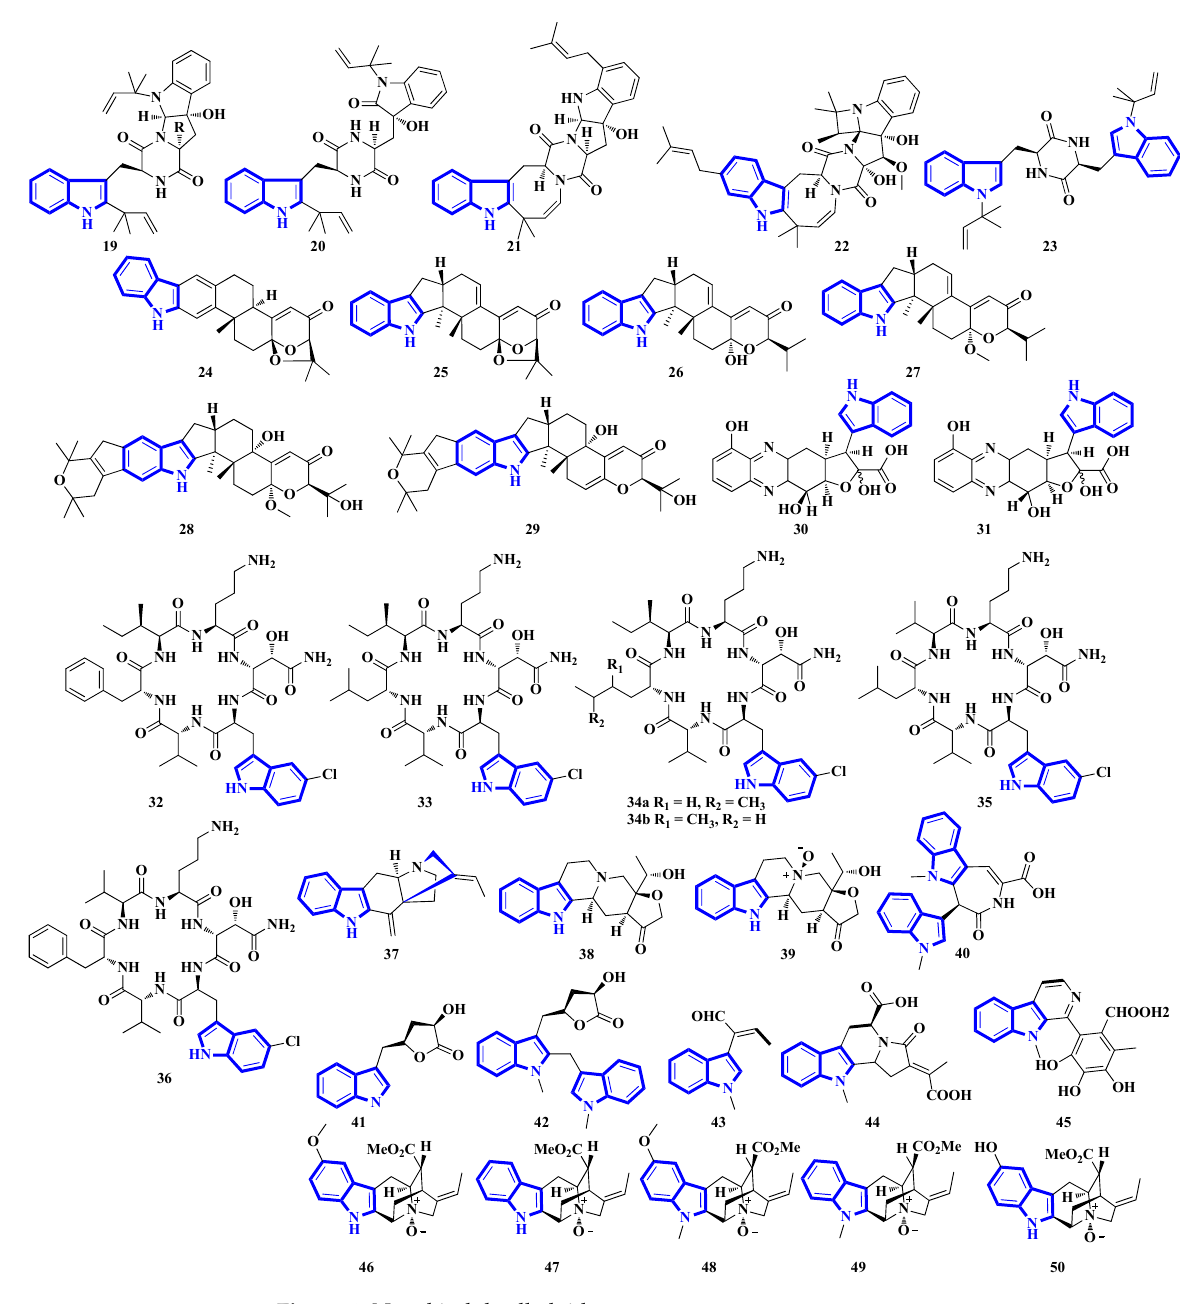
Figure 4. Novel indole alkaloids 19 to 50